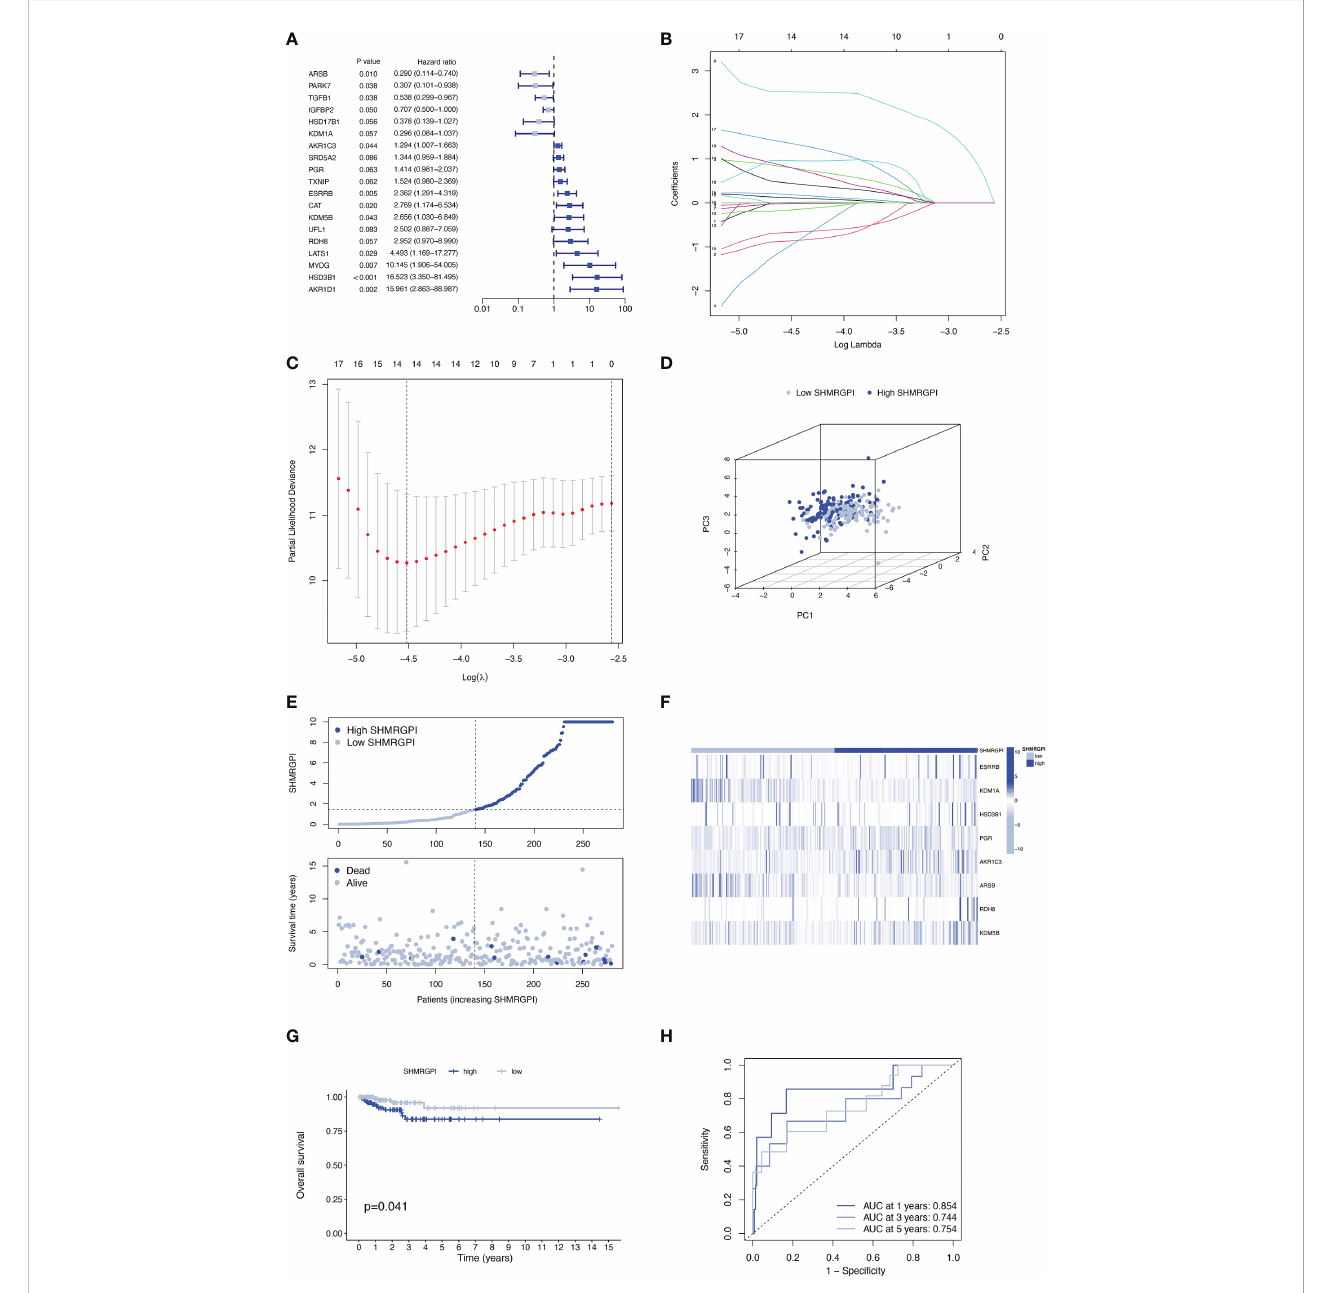
FIGURE 2 Establishment of the SHMRGPI in the train cohort. (A) Univariate Cox regression analysis for screening prognostic SHMRG. (B, C) LASSO regression analysis for variable selection. (D) PCA plot for different SHMRGPI groups. (E) Scatter diagram for the SHMRGPI and survival status of EEC patients. (F) Heat map for the expression of SHMRG and SHMRGPI groups. (G) Kaplan – Meier curves of survival difference between SHMRGPI groups. (H) ROC for predicting the sensitivity and speci fi city of survival according to the SHMRGPI. SHMRGPI, sex hormone metabolism-related gene prognostic index; LASSO, least absolute shrinkage and selection operator; PCA, principal component analysis; EEC, endometrioid endometrial cancer. ROC, receiver operating characteristic